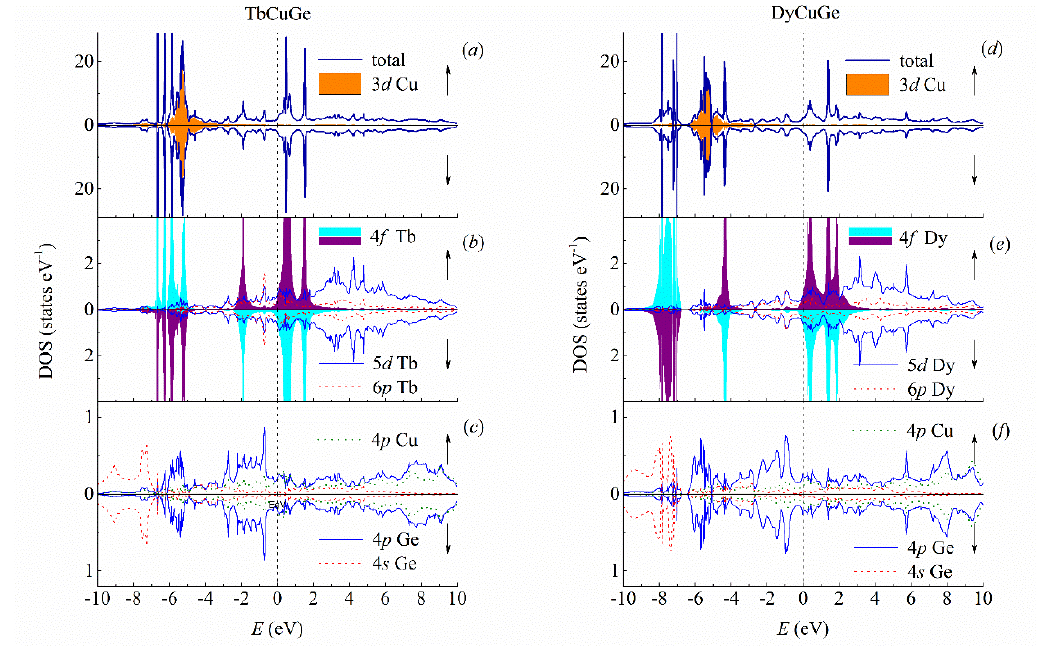
Figure 2. Calculated ab initio densities of states of TbCuGe and DyCuGe. ( a ) Total density of states of TbCuGe and Cu-3d densities; ( b ) densities of states for Tb-4f, Tb-5d and Tb-6p; ( c ) densities of states for Cu-4p, Ge-4p and Ge-4s in TbCuGe; ( d ) total density of states of DyCuGe and Cu-3d densities; ( e ) densities of states for Dy-4f, Dy-5d and Dy-6p; ( f ) densities of states for Cu-4p, Ge-4p and Ge-4s in DyCuGe. Dashed vertical lines show Fermi energy.